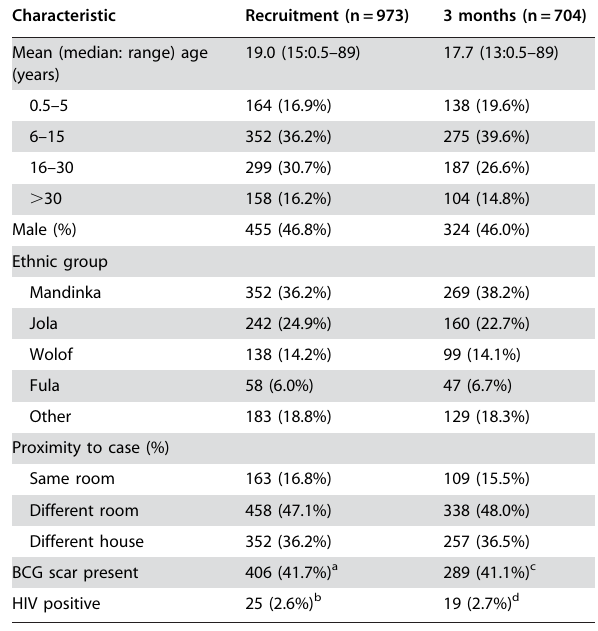
Table 1. Characteristics of TB case contacts who were negative by tuberculin test and ELISPOT at recruitment and those who had a repeat skin test at 3 months. .. ... .... ... ... .... ... ... .... ... ... .... ... ... .... ... ... .... ... ... ....